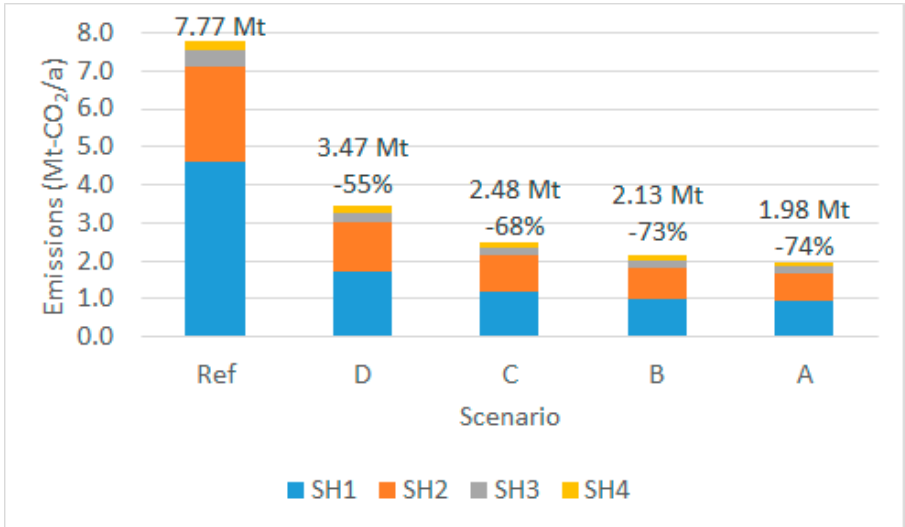
Figure 13. Absolute carbon emissions of the whole detached house building stock in Finland in the reference and optimized scenarios. The numbers show the remaining total CO 2 emissions and the relative reduction compared to the reference